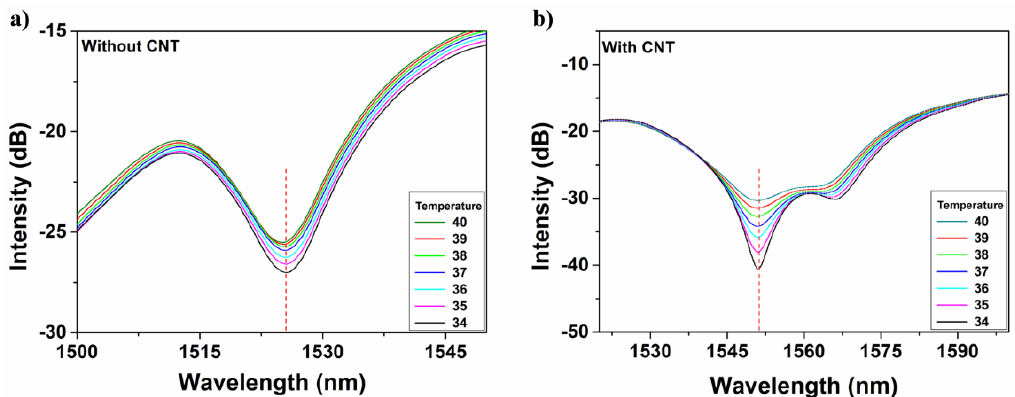
Figure 5. The spectra of temperature and interference intensity without ( a ) and with ( b ) CNT coating.